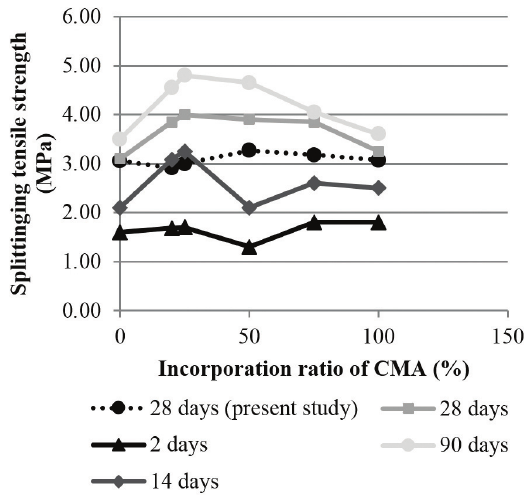
Figure 9. Splitting tensile strength result: Hebhoub et al. 5 vs. present study.